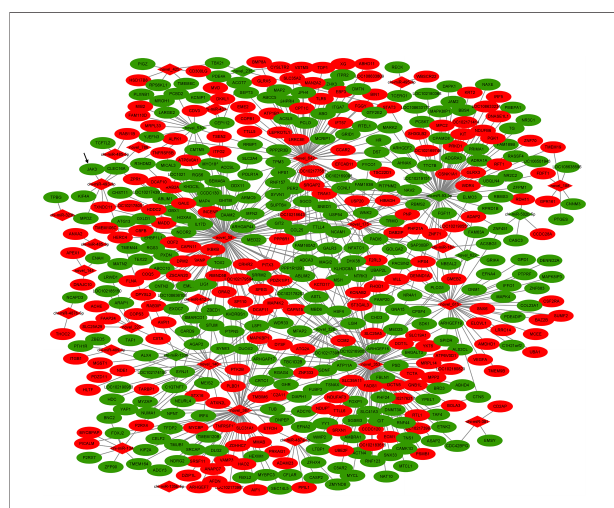
FIGURE 2 | The DE miRNA – mRNA interaction network in the comparison. Red color: upregulated; Green color: